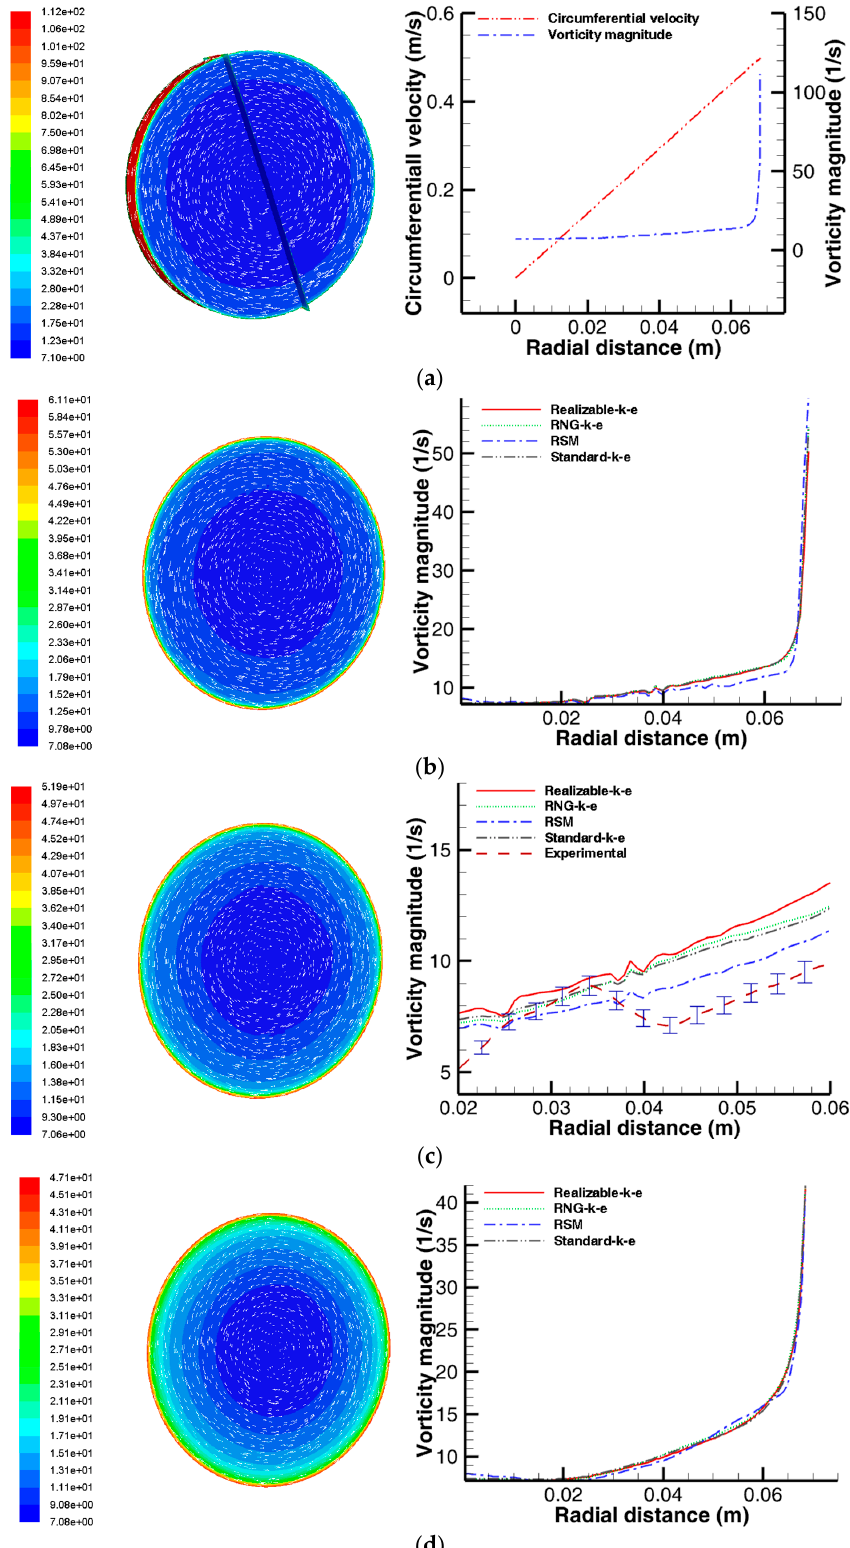
Figure 6. Reactor cross sections showing the vorticity vector maps and contours RNG- k - ε model and radial vorticity magnitude profiles along Y-Z plane at N = 70 rpm ( a ) rotating disc boundary layer; ( b ) x = 0.0015; ( c ) x = 0.003725; ( d ) x = 0.006.